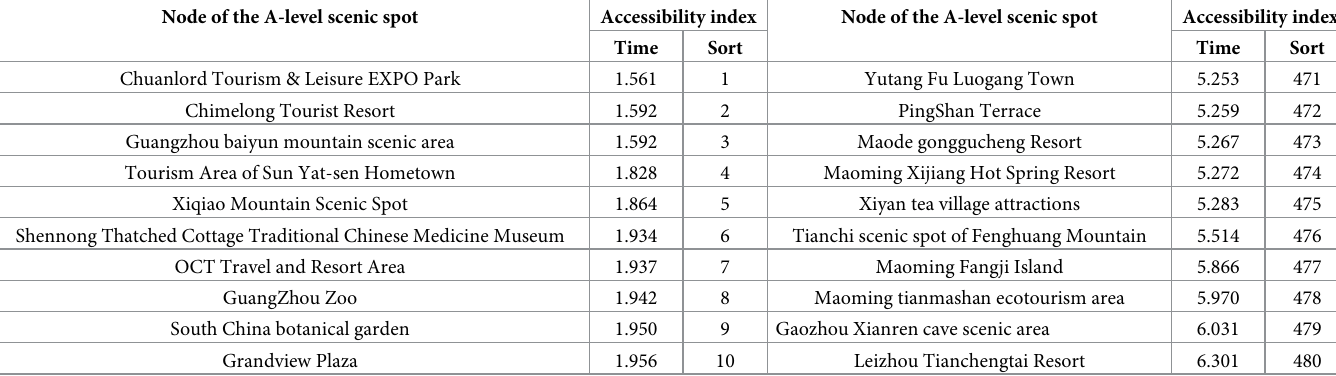
Table 5. Comparison of accessibility for 480 A-level scenic spots in Guangdong Province. Node of the A-level scenic